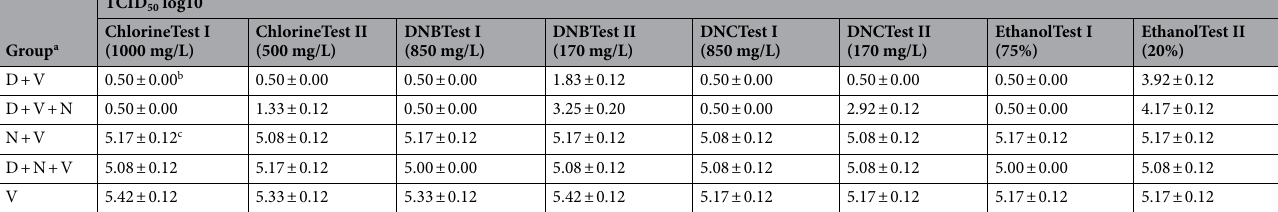
Table 2. Neutralizer identification test results. a D disinfectant, V viral suspension, N neutralizer. b If the value is equal to 0.5, we did not find a live virus after the treatment. c If this value is bigger than 5, which means the virus is not affected. The small variation in the values is due to small changes in the virus titers used in different